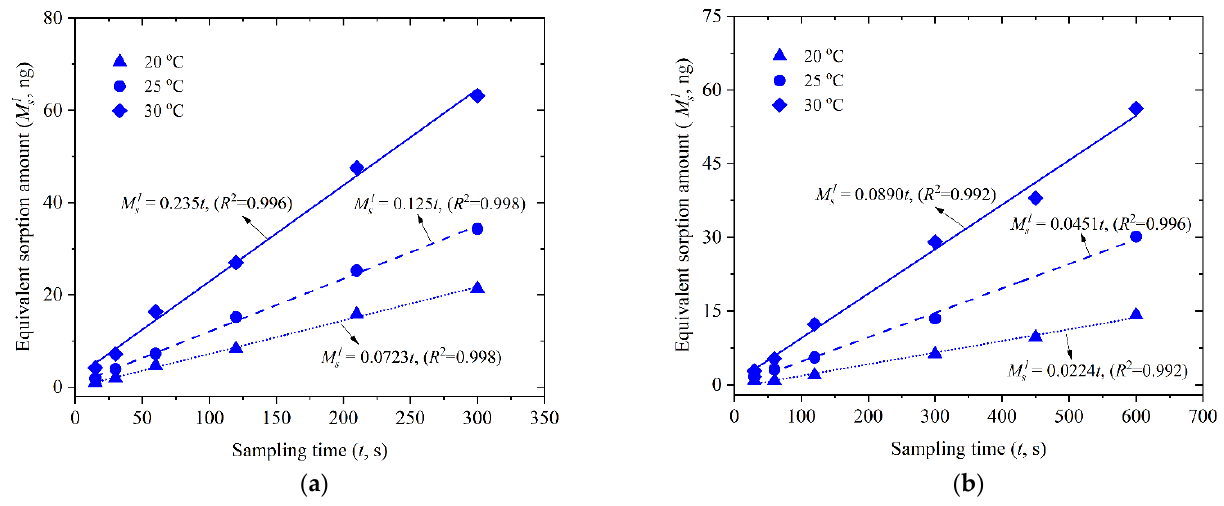
Figure 3. Comparison between experiment results and the lines fitted using Equation (6) for ( a ) DiBP and ( b ) TCPP. R 2 is the square of the correlation coefficient of linear fitting. Slope of the fitted line divided by the corresponding gaseous concentration equals the SPME calibration constant ( β ).